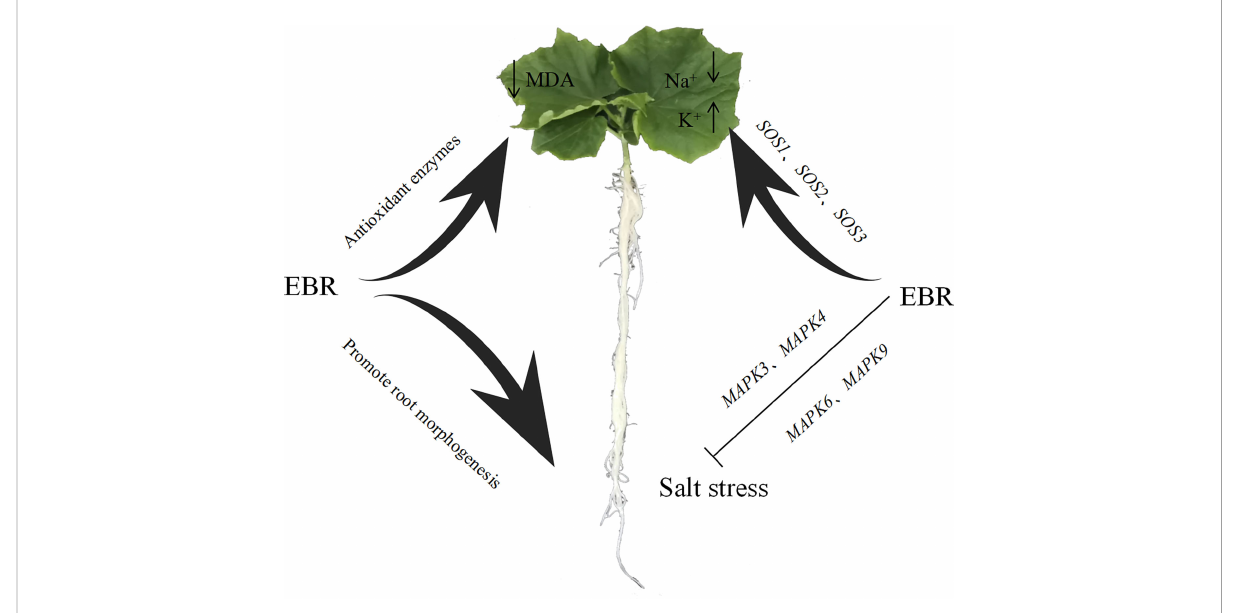
FIGURE 10 Schematic diagram for the effect of EBR on salt stress. The Figure illustrates the pathway by which EBR alleviates salt stress through different